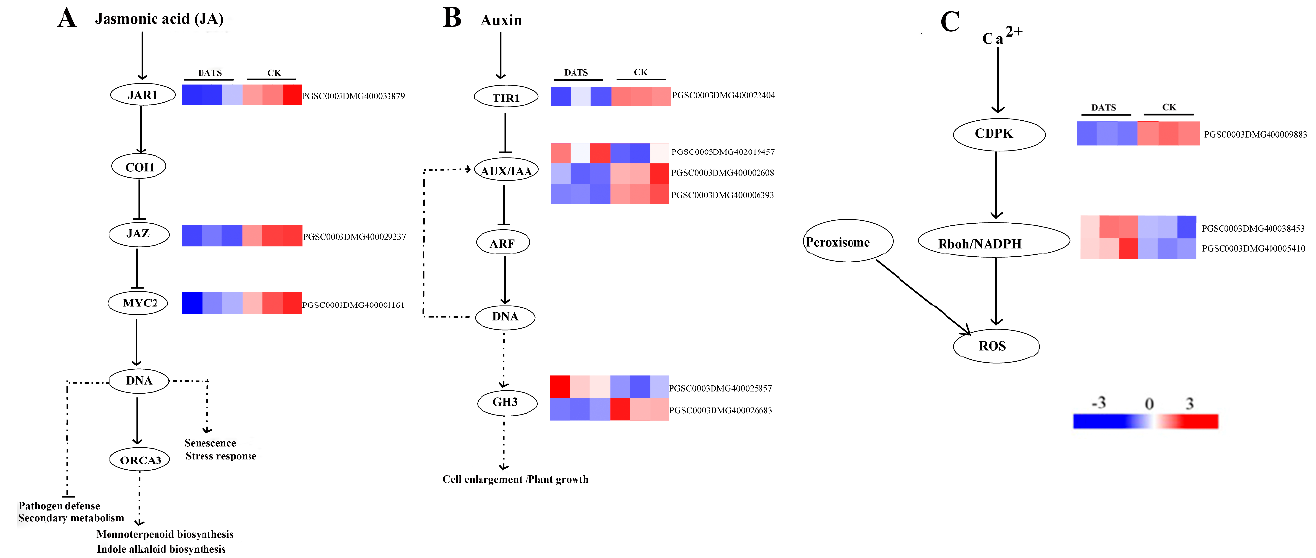
Figure 4. Effects of DATS treatment on the regulation of jasmonic acid signal pathway ( A ), auxin signal pathway ( B ), and ROS biosynthesis ( C ).